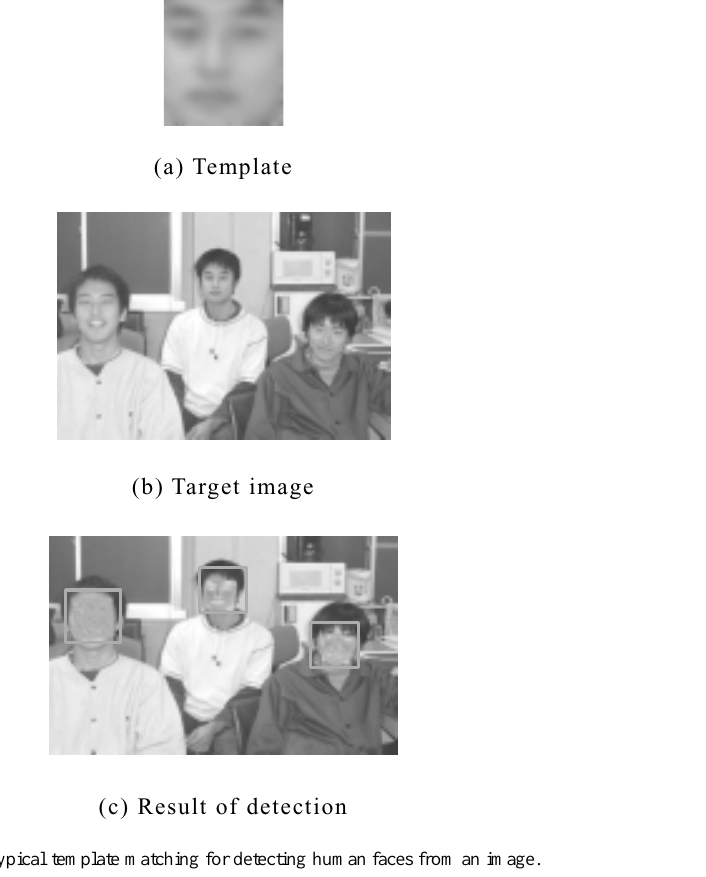
Fig. 4. A typical template matching for detecting human faces from an